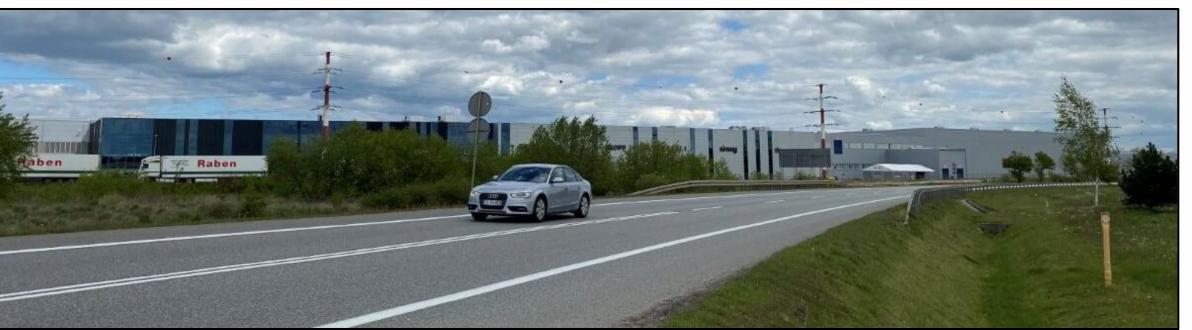
Figure 6. Warehouses of the LPP S.A. clothing company in Pruszcz Gda´nski (photo taken by A. ´Swi